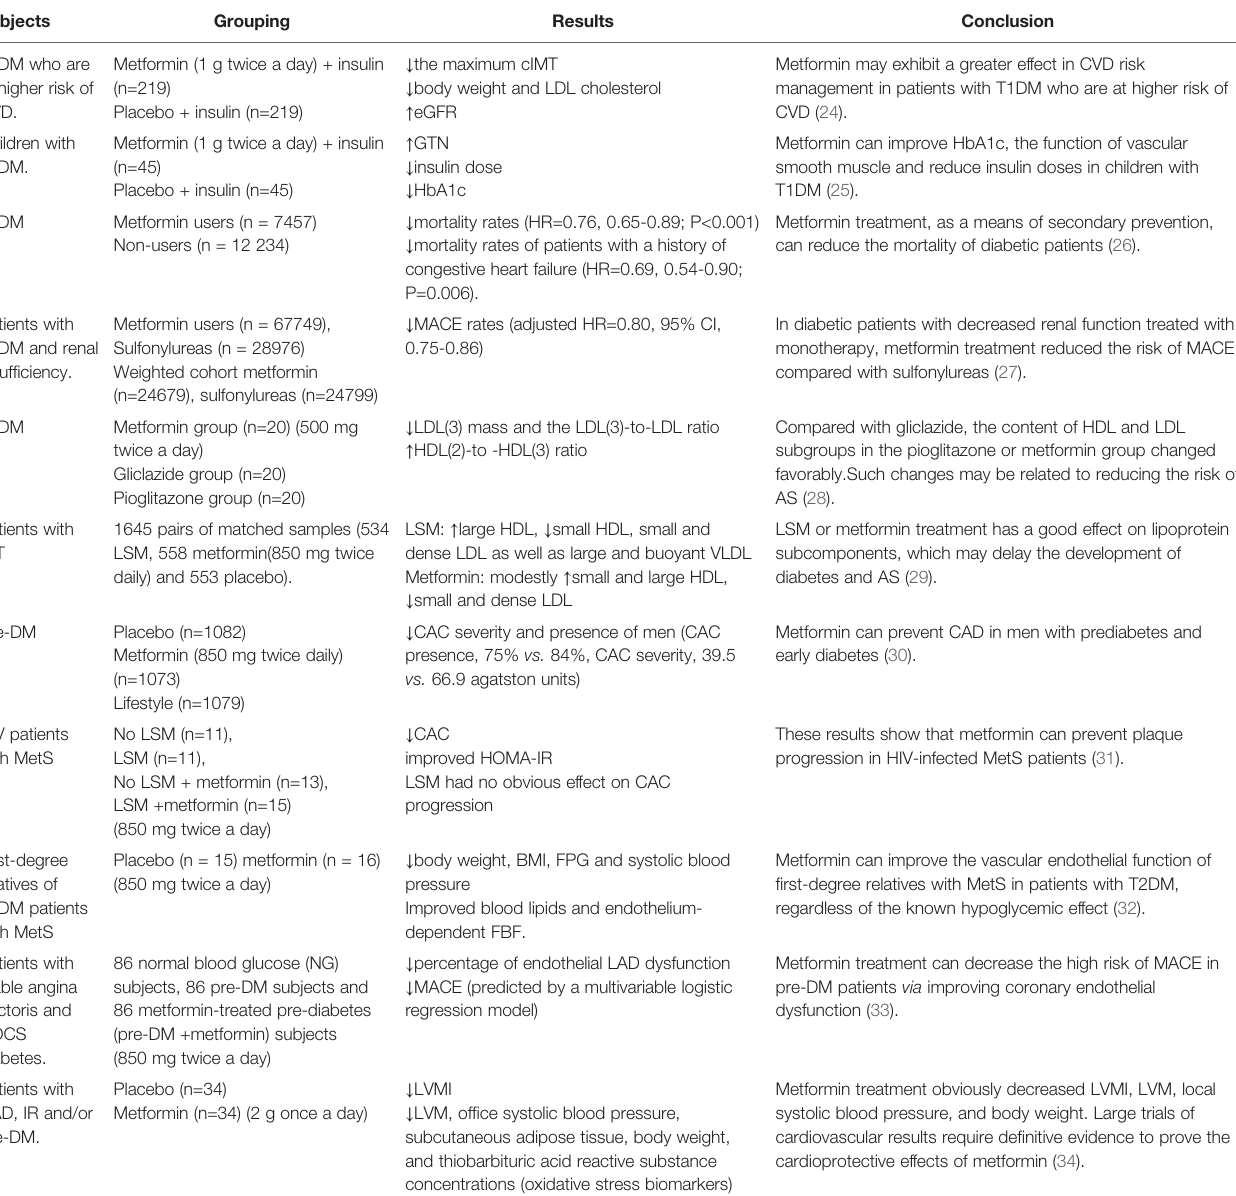
TABLE 1 | Clinical studies of metformin in diabetic patients with cardiovascular